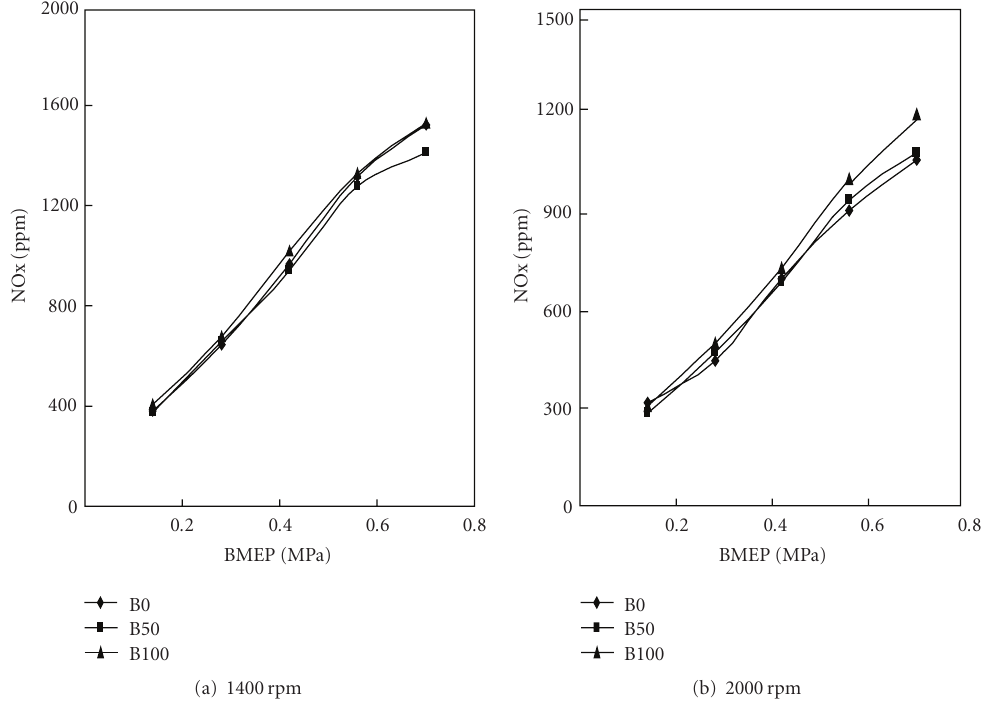
Figure 7: E ff ect of the rapeseed oil monoester on NOx emissions.